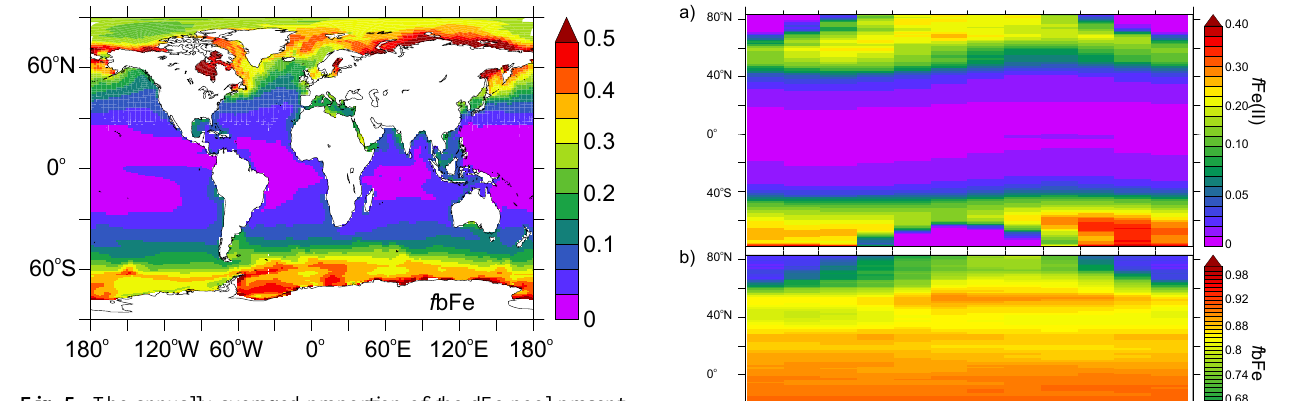
Fig. 6. Seasonal variability (monthly averages) in the zonally aver- aged proportion of the dFe pool present as (a) Fe(II) and (b)